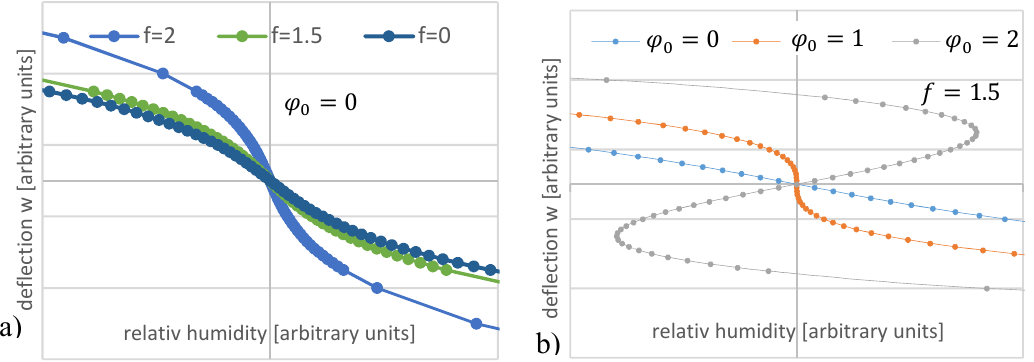
Figure 12. Calculated deflection w of a rectangular bending plate in dependence of the deflection angle ϕ from Equation (81): ( a ) with the pre-deflection angle ϕ = 0 and variable f; ( b ) with the variable pre-deflection angle ϕ 0 and f = 1.5.